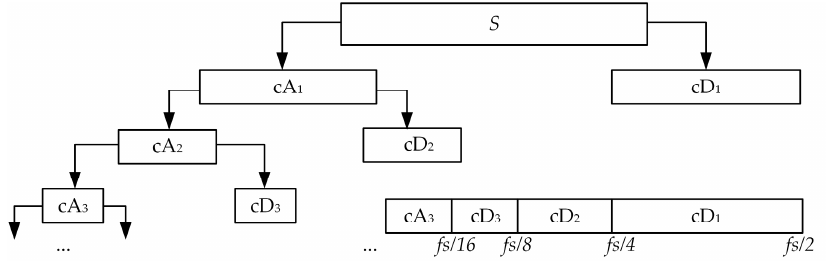
Figure 2. Time-space diagram for a line monitored at two terminals. CCVT—coupling capacitor voltage transformers.